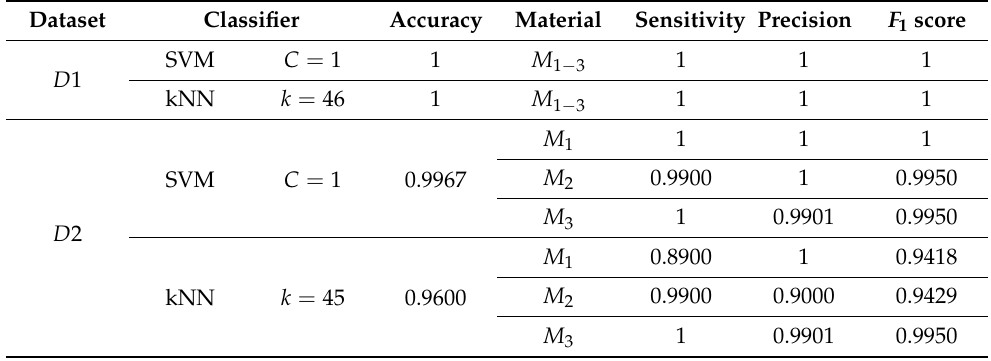
Table 4. Classification results for datasets D 1 and D 2 for the optimised parameters C and k